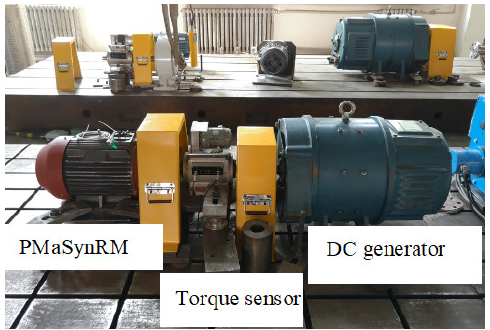
Figure 26. The inductance test of the prototype.